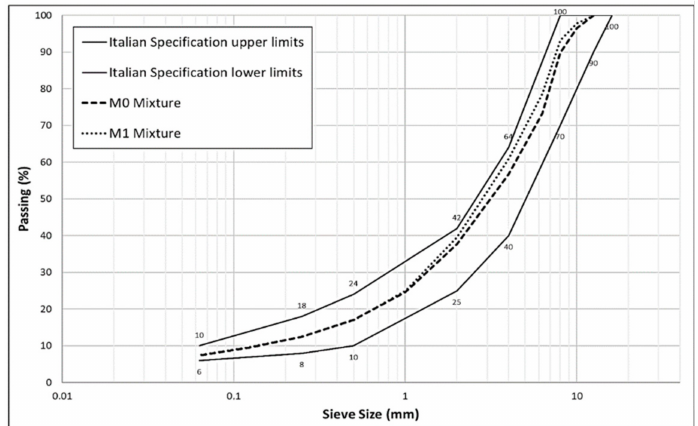
Figure 5. Asphalt mixtures